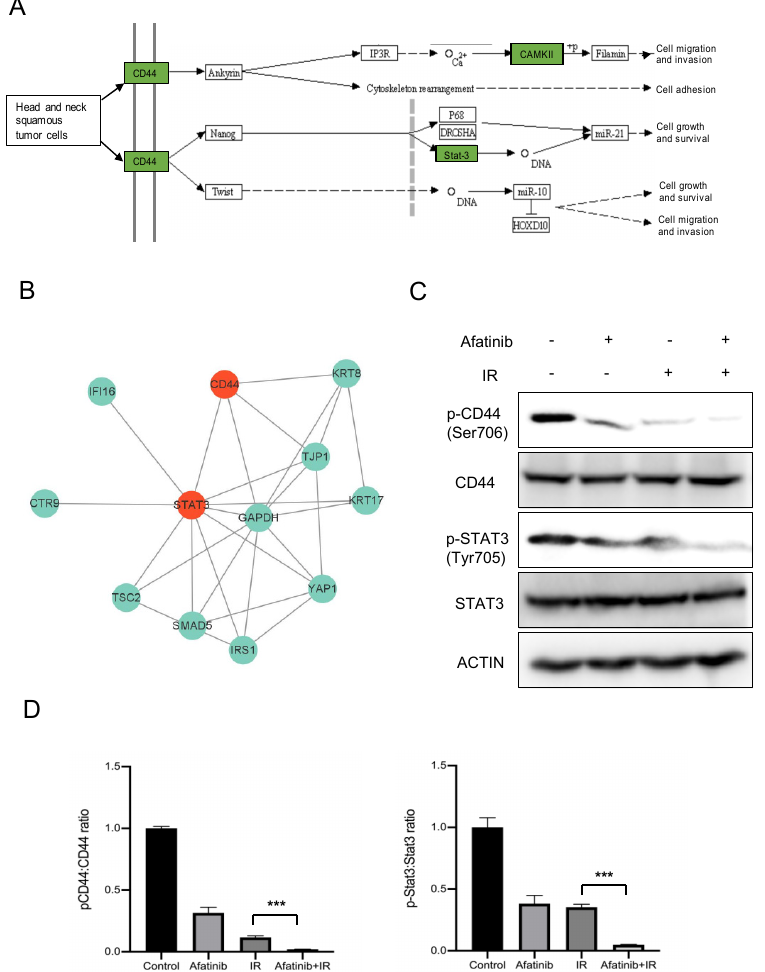
Figure 4. Phosphorylated proteomics analysis revealed influence on CD44-Stat3 axis. ( A ) Functions of the proteoglycans in cancer signaling pathway were presented. ( B ) DEPs interacted with CD44 and Stat3 were analyzed. ( C , D ) HNE2 cells were treated with afatinib or IR, WCLs were prepared at 24 h post-treatment and analyzed by immunoblotting with indicated antibodies ( C ). the statistical analysis is shown in ( D ). *** denotes p < 0.001. Error bars represent ±SD of triplicate experiments.